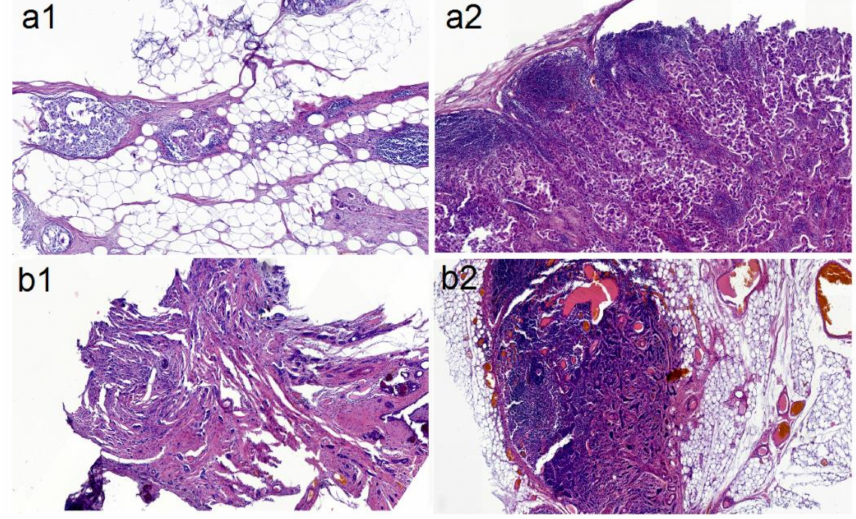
Figure 1. Microscopy images of the ( 1 ) breast cancer tissues and ( 2 ) LNs collected from the ( a ) I and ( b ) II groups of